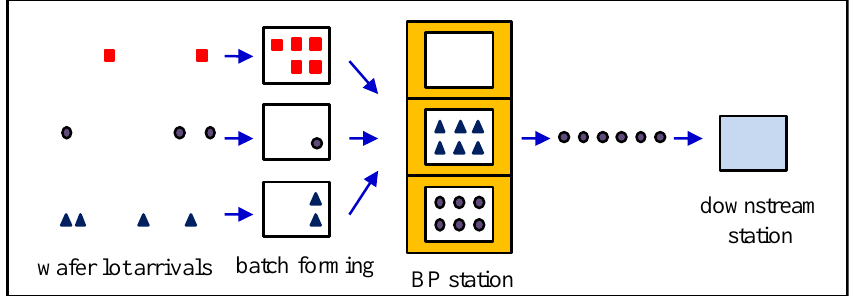
Figure 1. Schematic representation of a batch processor (BP) station with multiple batch processors.